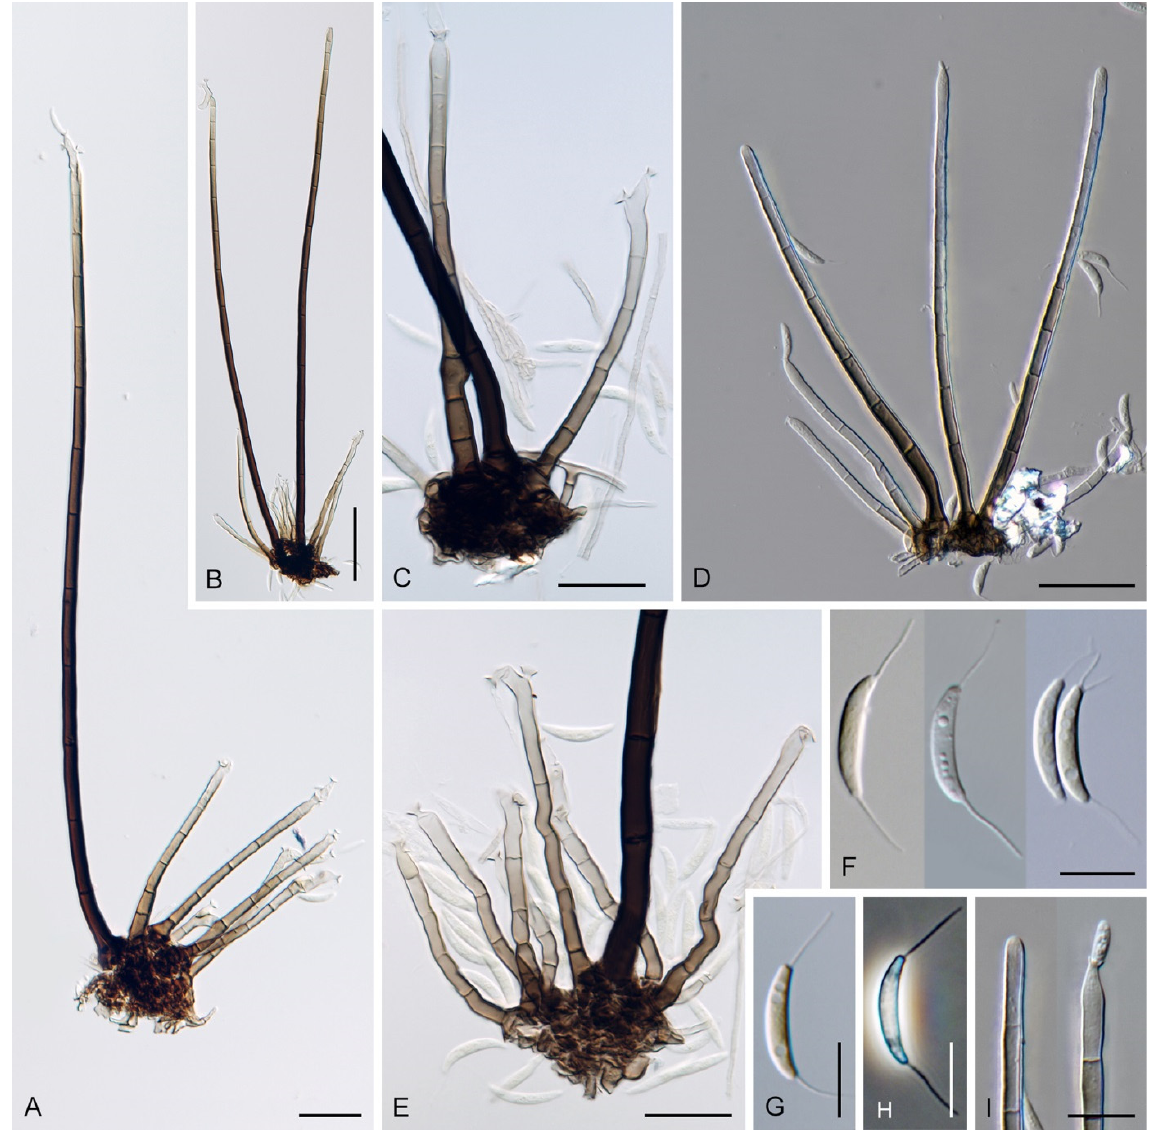
Figure 12. Codinaea assamica (CBS 139907 ex-type of C. acaciae ). ( A – E ) Setae with conidiophores ( F – H ) conidia ( I ) apical part of the setae. Images: ( A – I ) on pine needles on SNA after 4 weeks. Scale bars: ( A , D ) 25 μ m; ( B ) 50 μ m; (C,E) 20 μ m; ( F – I ) 10 μ m.